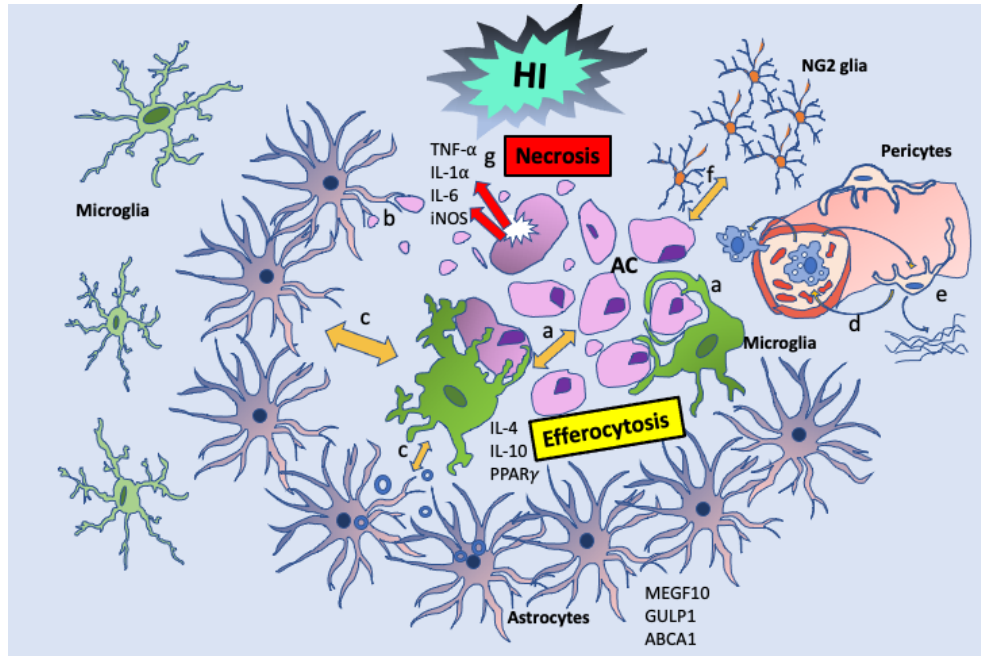
Figure 3. Efferocytosis crosstalk in HI: The AC reprograms efferocytes to express specific gene signatures that regulate the morphologic, metabolic, and inflammatory state of efferocytes. Mi- croglia accumulate at the injury site, where they touch, engulf, and enwrap the AC ( a ). Astrocytes locate to the penumbra and participate in phagocytosis of synaptic debris ( b ) [122]. Astrocytes and microglia reciprocally inhibit or stimulate their efferocytic function and anti-inflammatory pheno- type ( c ) [123–125]. Pericytes recruit macrophages and enhance their phagocytic activity ( d ) and macrophages stimulate pericytes to produce extracellular matrix proteins ( e ) [98]. NG2 glia fill-in the empty space following AC removal and support neuroregeneration by remyelination and/or conversion to neurons or astrocytes ( f ) [111,112]. The defective efferocytosis leads to secondary necrosis and inflammation ( g ), while well-functioning efferocytosis promotes